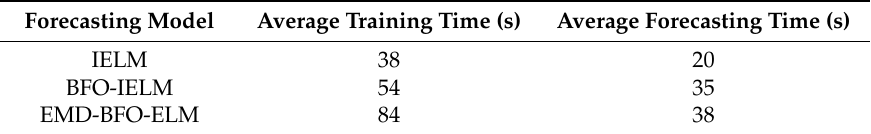
Table 5. Comparison of training and prediction time for the three predictive models.